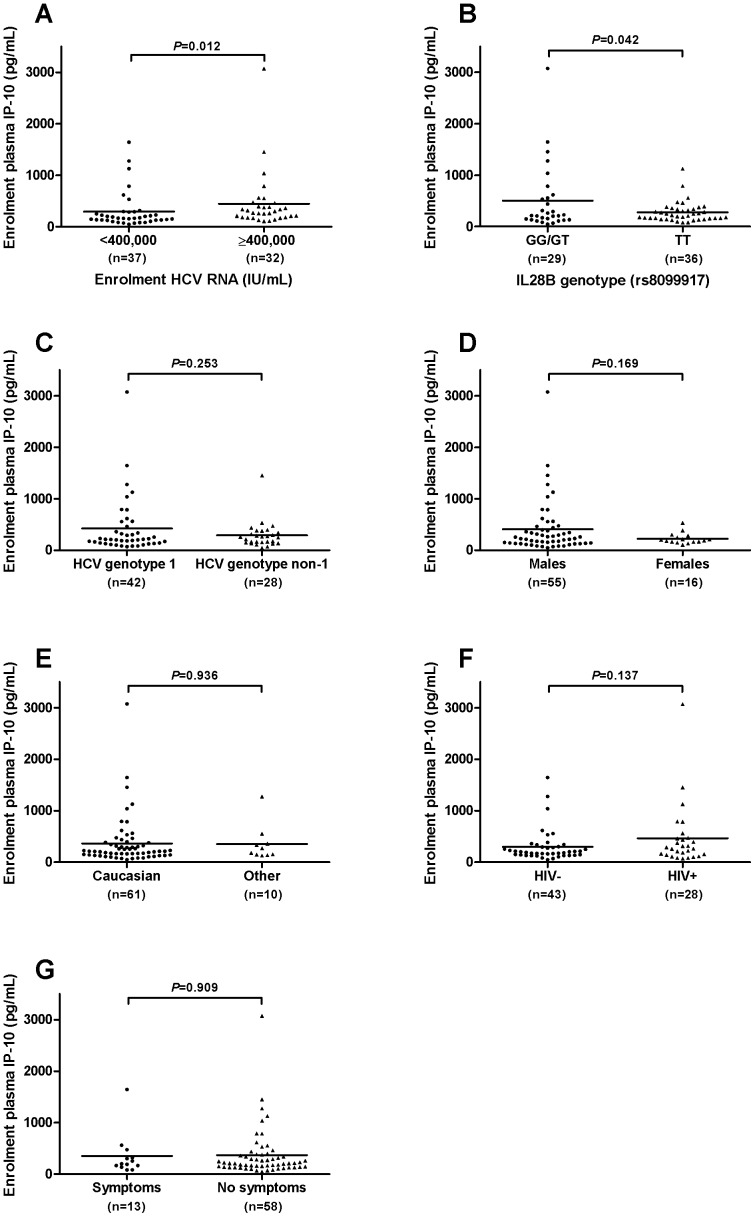
Baseline plasma IP-10 values according to patient characteristics.Baseline plasma IP-10 levels are shown by: a) HCV RNA above or below 400,000 IU/mL b) IL28B genotype c) HCV genotype (1 vs. non-1) d) sex e) ethnicity (Caucasian vs. other) f) HIV status and g) the presence or absence of symptoms at presentation. Mean plasma IP-10 levels were compared using the student’s t-test with Welch’s correction for unequal variances as appropriate.